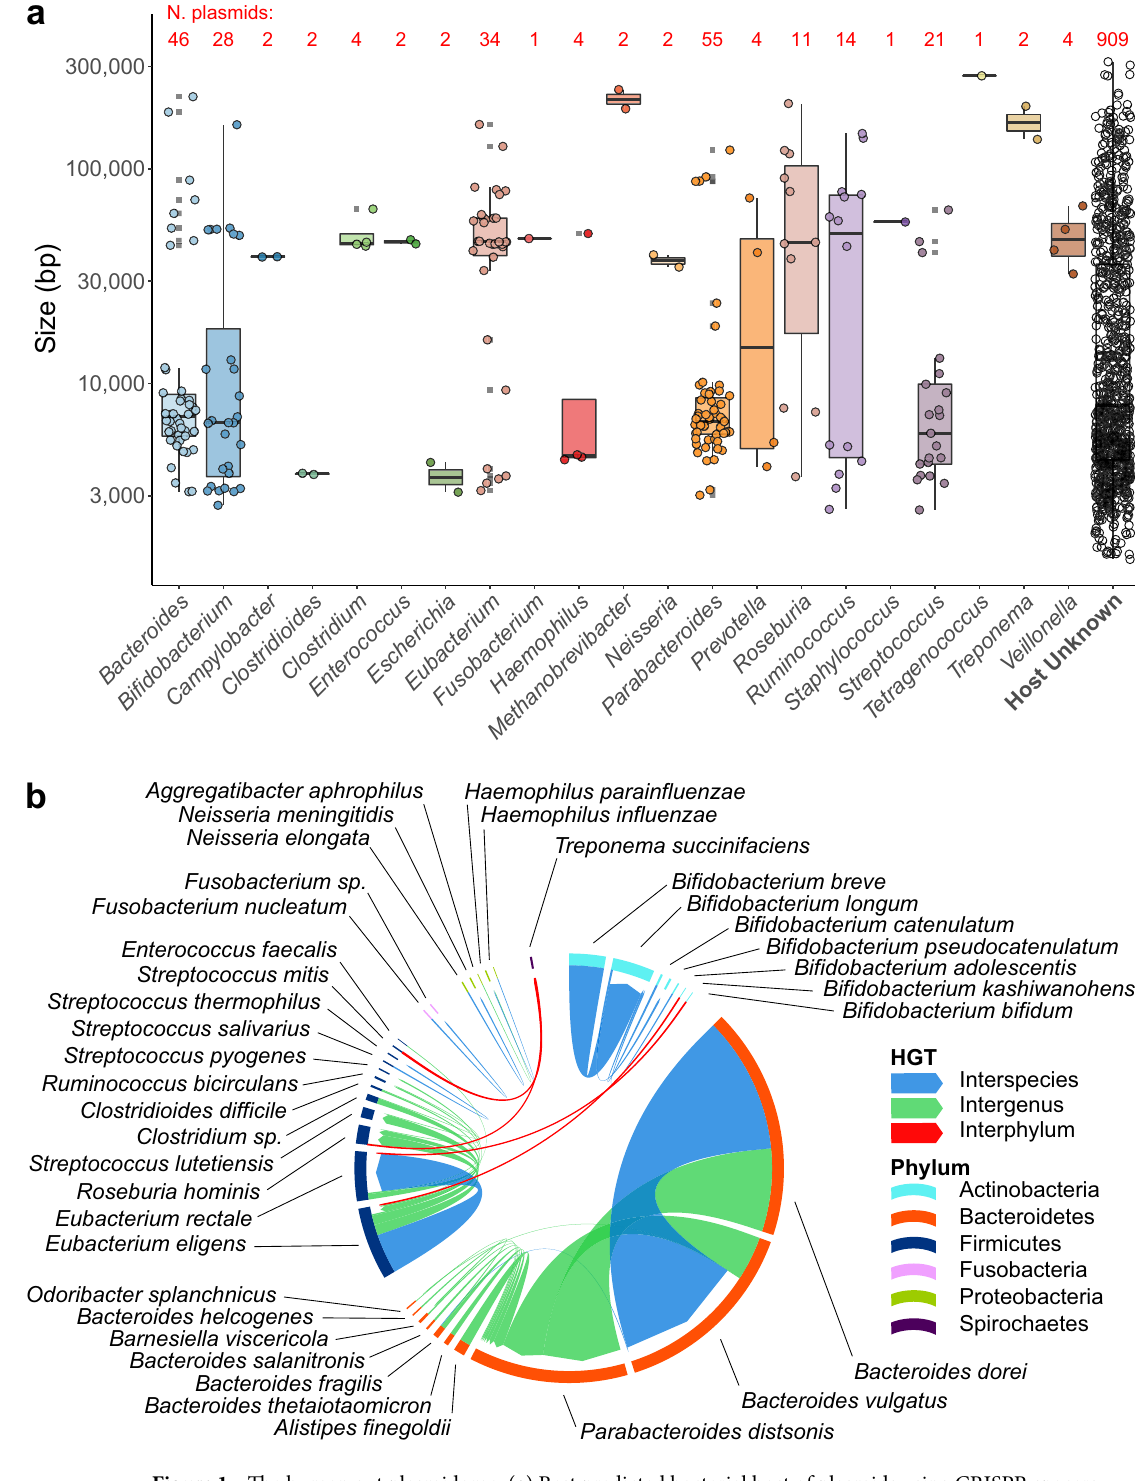
Figure 1. The human gut plasmidome. ( a ) Best predicted bacterial host of plasmids using CRISPR spacers. The number of plasmids per host genus is indicated in red along the top. ( b ) HGT demonstrated by plasmids targeted by CRISPR spacers from two or more bacterial hosts. The outer circle’s colour indicates plasmid source phylum, while the colour and width of arrows indicating type and number of connections between taxa,